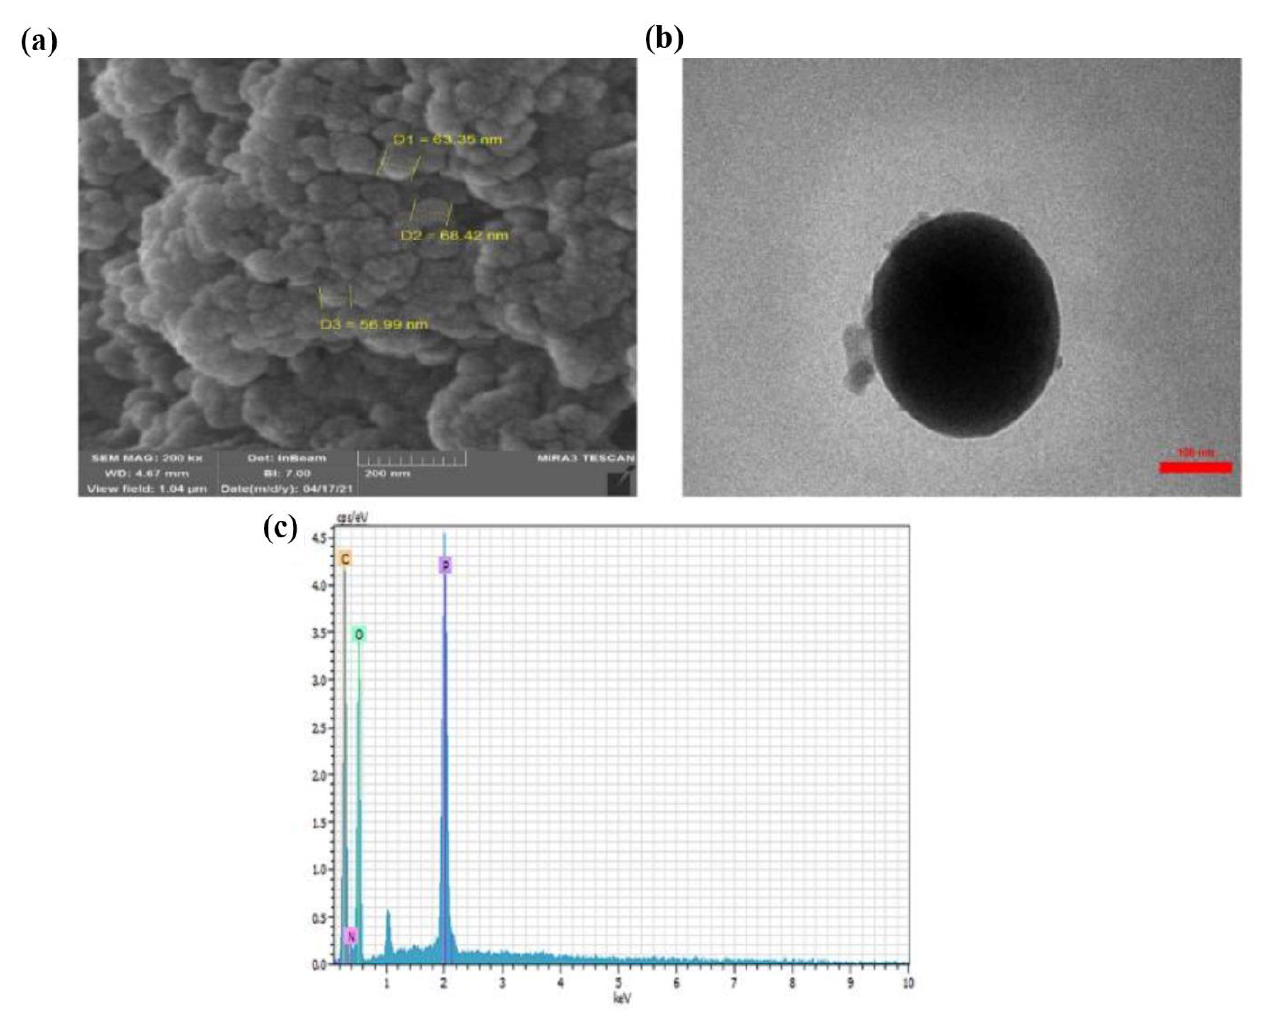
Figure 1. SEM ( a ) TEM ( b ), and EDS ( c ) analysis of CTS-Pro NPs.